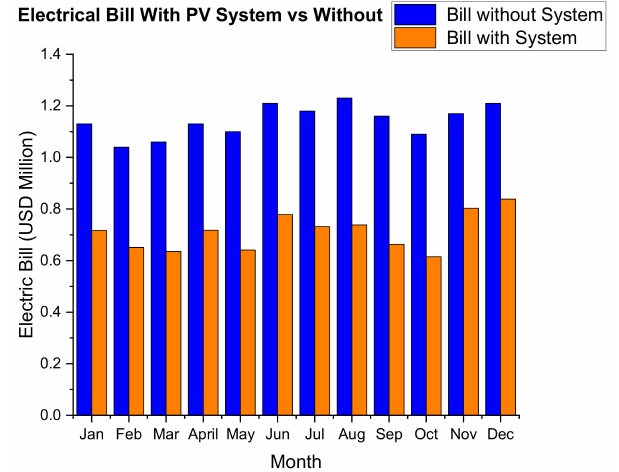
Figure 13. Monthly electricity bill with the PV system vs.